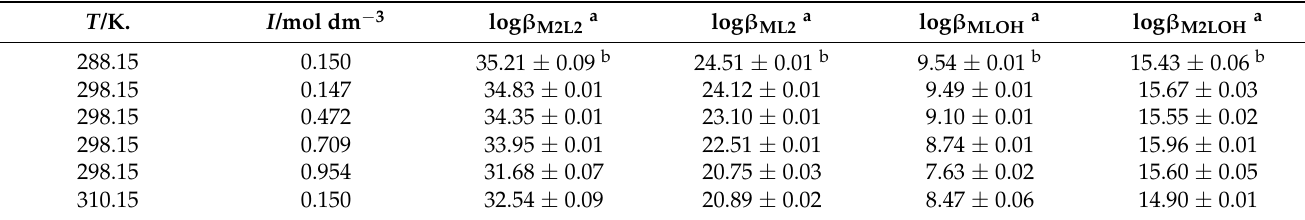
Table 6. Experimental formation constants of the Sn 2+ /Dop − species in NaCl aqueous solutions. T /K.